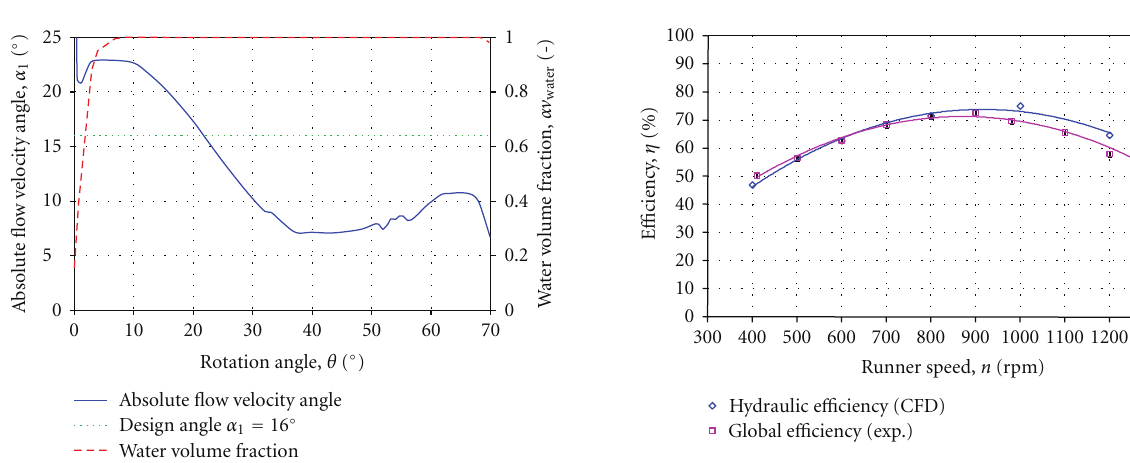
Figure 9: Absolute flow velocity angle and water volume fraction along the rotation angle at midspan of nozzle-casing domain.